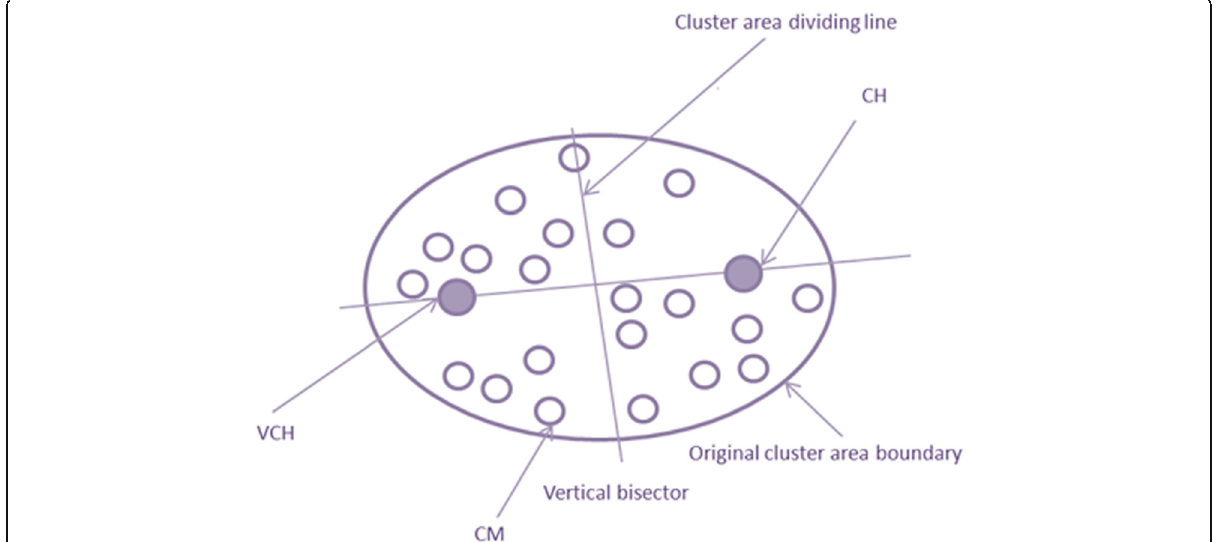
Fig. 2 Segmentation map of the cluster local